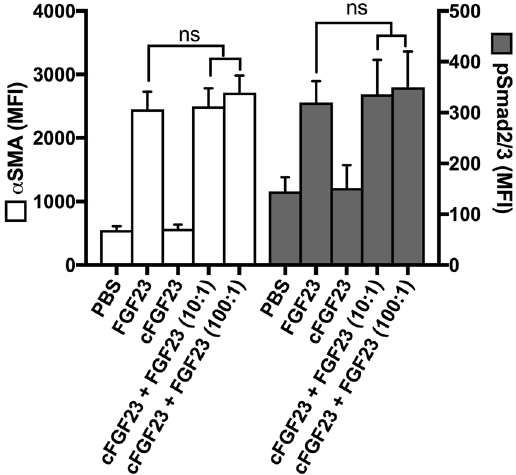
Figure 7. C-terminal FGF23 fragments have no effect on fibroblast activation. Quantitative flow cytometric analysis of intact FGF23 and c-terminal FGF23 (cFGF23), alone or in combination, on changes in α SMA and pSmad2/3levels (mean fluorescence intensity, MFI) in UUOF after 24 h treatment. Data are shown as mean ± SD and are representative of four independent experiments all with similar results. ns, not significant. P-values were determined by one-way ANOVA with Holm-Sidak multiple comparisons